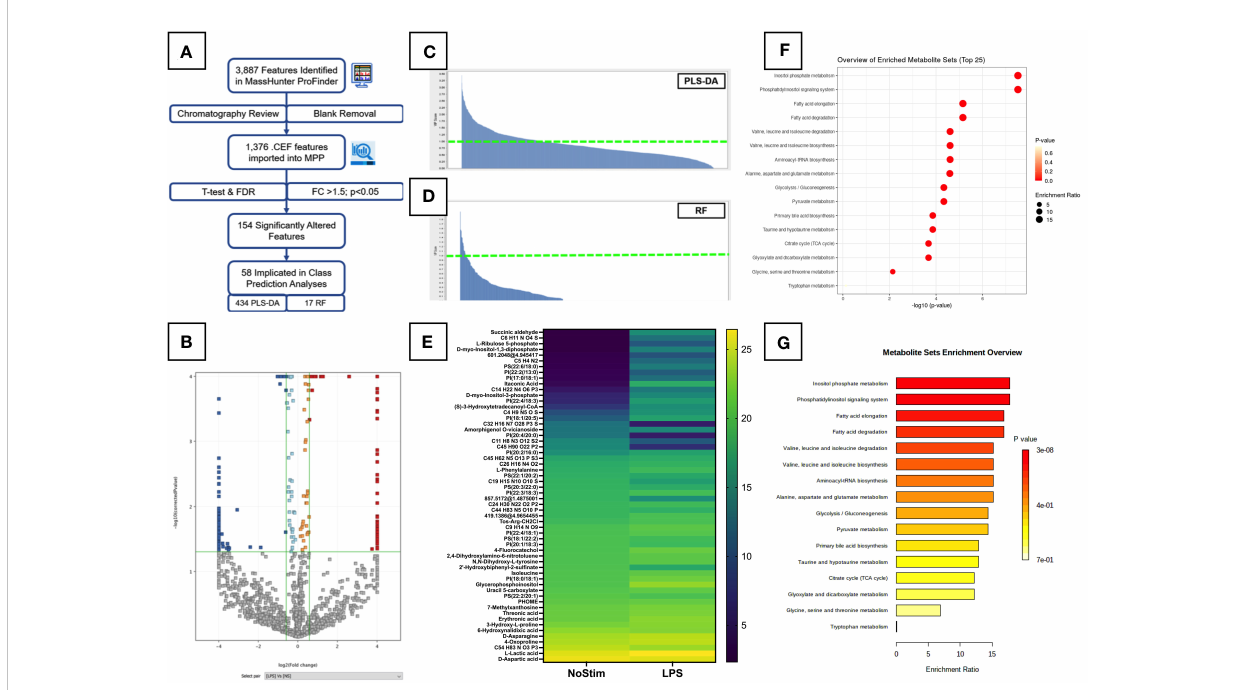
FIGURE 3 Untargeted Metabolomic Analysis of LPS Stimulated Primary Monocytes. (A) Summary work fl ow for untargeted metabolomic analysis with numbers of features/entities speci fi ed at each stage. (B) Volcano plot of LPS-treated monocytes are shown with signi fi cantly upregulated features highlighted in red and downregulated features in dark blue. Light blue and orange features did not meet the fold change threshold limits, and grey features were insigni fi cant. Fold change and p-value thresholds are shown in green lines on the X and Y axes respectively. Class prediction analyses of signi fi cantly altered untargeted metabolites carried out by PLS-DA (C) and Random Forrest analysis (D) . Entities with a VIP score >1 are plotted on the heatmap in (E) . Pathway analysis of signi fi cantly altered metabolites identi fi ed in untargeted analysis was performed on the online MetaboAnalyst platform (Version 5.0, https://www.metaboanalyst.ca/). Results are displayed as dot plots (F) and bar chart (G)